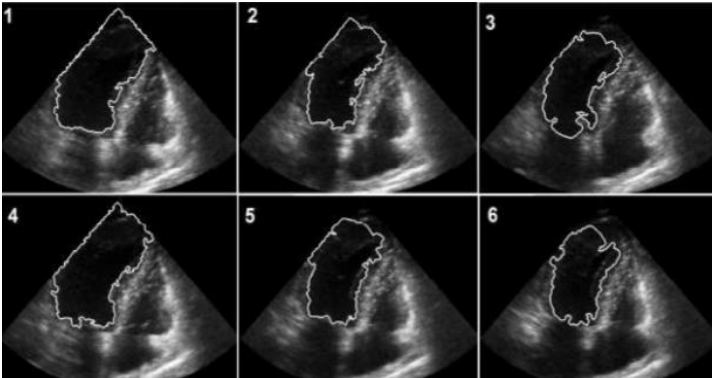
Figure 5. Output of the pre-processed image.